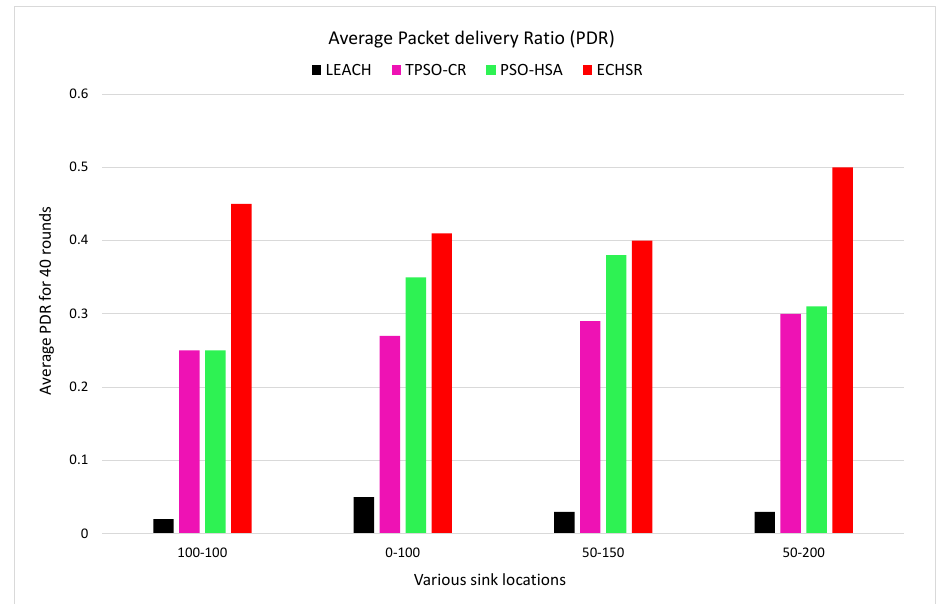
Figure 13. Packet delivery ratio (PDR) for various sink locations in forest fire scenarios and 40 rounds of the